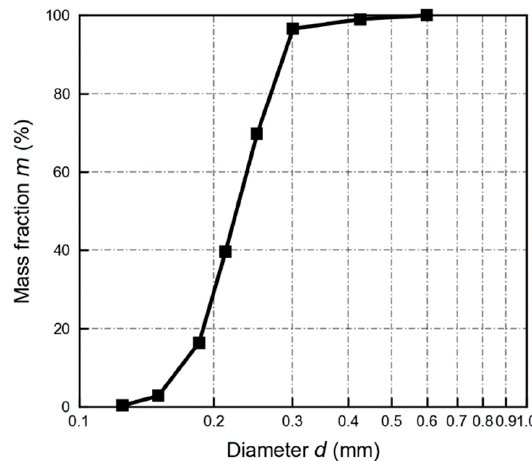
Figure 1. Cubic specimen with particles in the DEM simulation (walls are omitted).